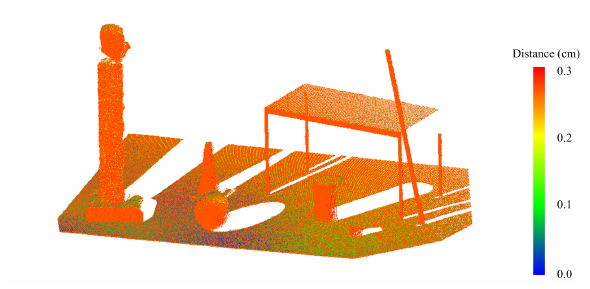
Figure 15: Distances after the fine registration